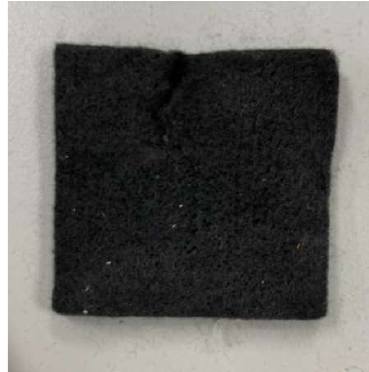
Figure 9. Carbon felt.